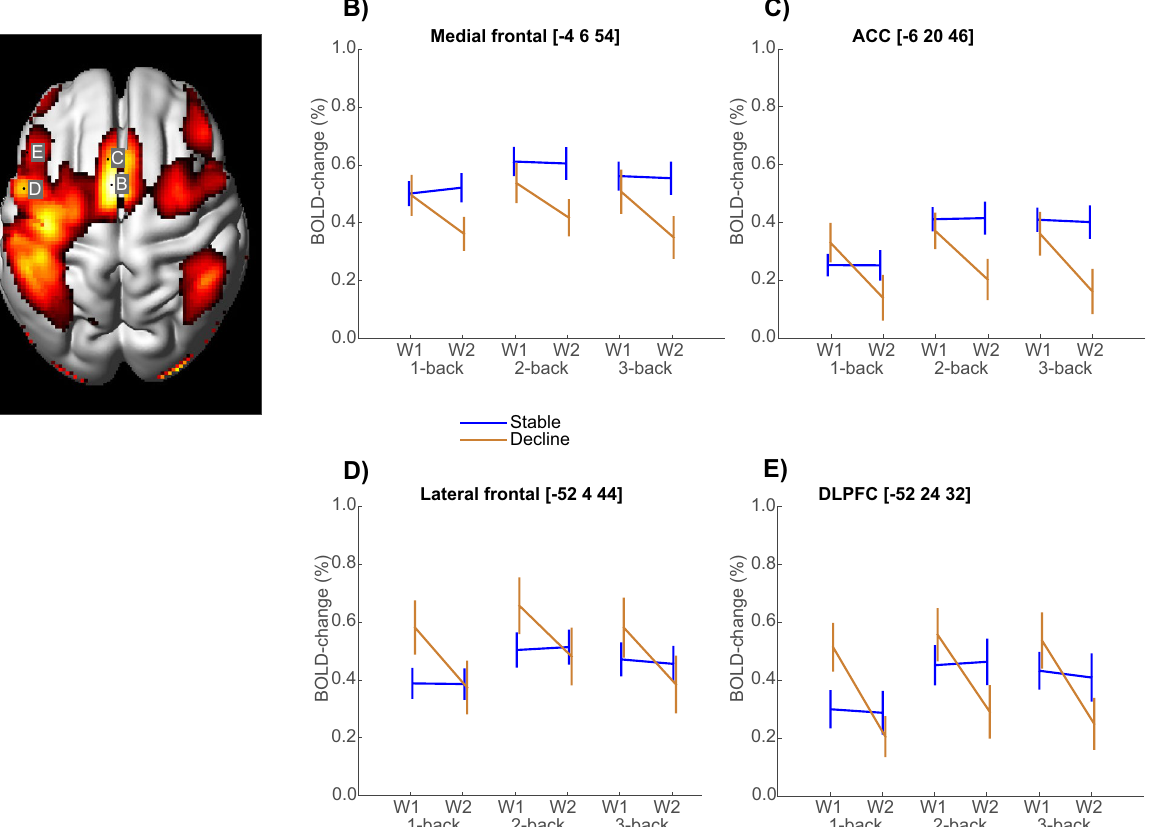
Figure 2. Functional brain activity during n -back tests of WM. ( A ) Brain regions showing differential BOLD signal during n -back in stable and declining persons (pFWE < 0.05). ( B – E ) Significant group differences in PFC longitudinal trajectories. (Mean ± 1SE). W =